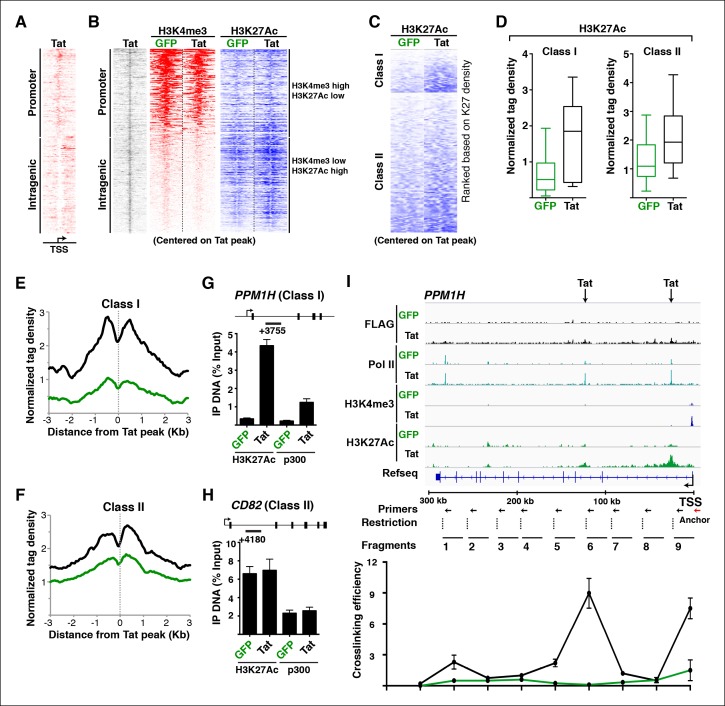
Tat induces transcription initiation from distal sites by inducing gene looping.(A) Heatmap representation of Tat distribution at TSG promoter or intragenic sites. (B) Heatmap representation of H3K4me3 and H3K27Ac tag density centered on the Tat peak at both TSG promoter and intragenic sites in the GFP and Tat cell lines. Promoter sites are marked with high H3K4me3 and low H3K27Ac levels, while intragenic sites are marked by low H3K4me3 and high H3K27Ac levels. (C) Heatmap representation of H3K27Ac at class I and class II TSG centered on the Tat peak in the GFP and Tat cell lines. Genes are ranked based on H3K27Ac density. (D) Tat binding sharply increases H3K27Ac levels at class I TSG. Box plots showing normalized H3K27Ac density at class I and II TSG in the GFP and Tat cell lines. (E) Metagene analysis of H3K27Ac levels surrounding Tat peaks at class I TSG in the GFP and Tat cell lines. (F) Metagene analysis of H3K27Ac levels surrounding Tat peaks at class II TSG in the GFP and Tat cell lines. (G) ChIP of H3K27Ac and p300 recruitment at an intragenic Tat site at the PPM1H gene. (H) ChIP of H3K27Ac and p300 recruitment at an intragenic Tat site at the CD82 gene. (I) Top, genome browser views of ChIP-seq at the PPM1H locus in the GFP and Tat cell lines. The arrows indicate the position of two intragenic Tat binding sites. Bottom, 3C assay showing the relative crosslinking efficiency at the PPM1H locus in the GFP and Tat cell lines. The position of the primers used in qPCR assays, restriction sites and fragment generated after digestion are indicated. This figure is associated with Figure 4—figure supplements 1–4. 3C, chromosome conformation capture; ChIP-seq, chromatin immunoprecipitation sequencing; GFP, green fluorescent protein; RNA-seq, RNA sequencing; TSG, Tat stimulated genes.